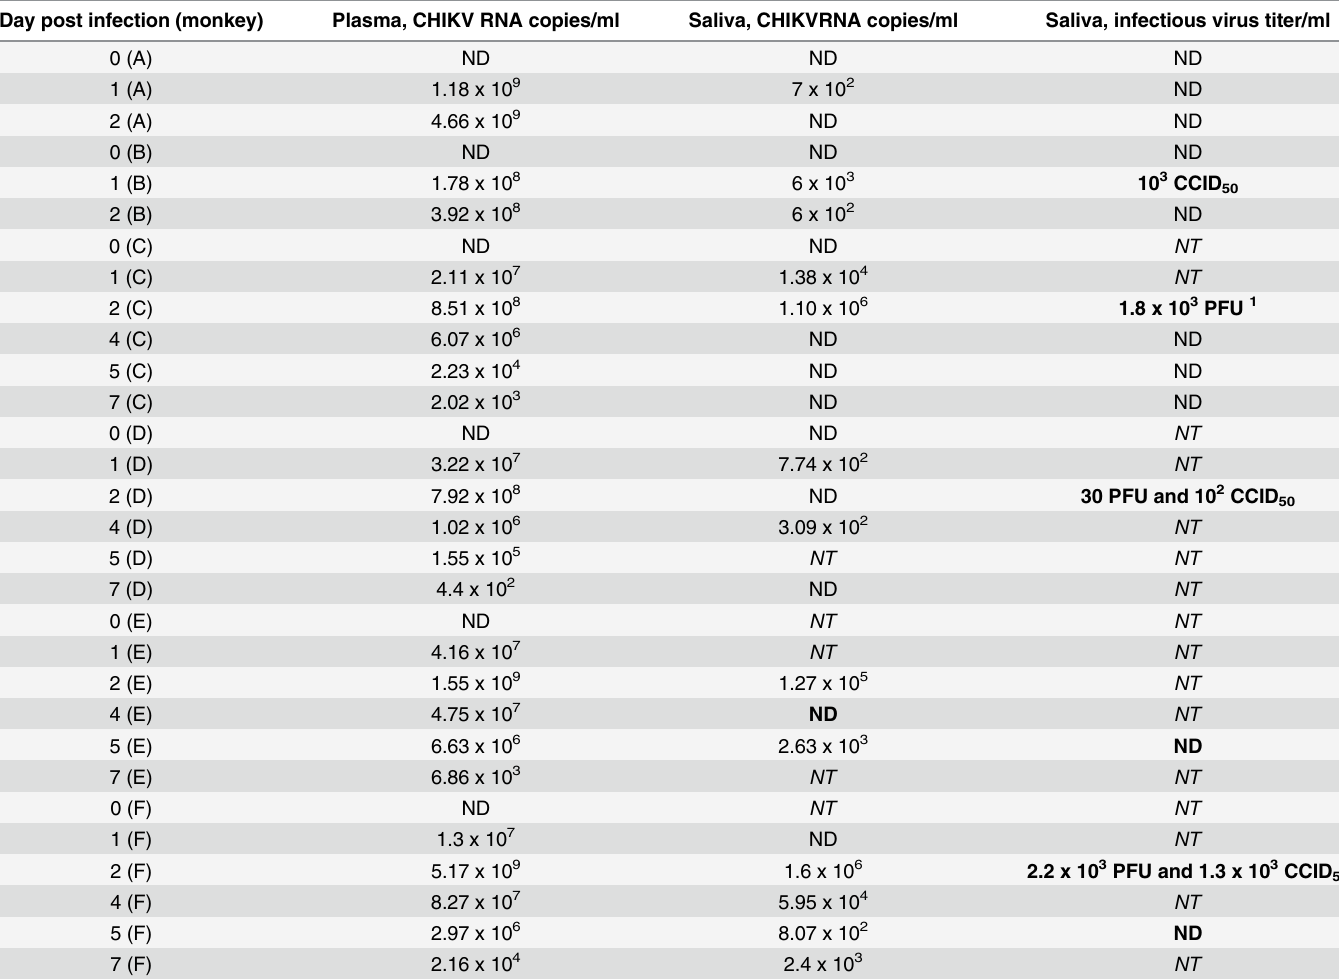
Table 2. Presence of CHIKV RNA and infectious CHIKV in the saliva of CHIKV infected cynomolgus macaques. Monkeys A and B were infected with 10 6 PFU and monkeys C-F with 4 x 10 3 PFU of CHIKV. Viral RNA copies were determined by quantitative real time RT-PCR; (the full data set for animals C-F is graphed in Fig C in S1 File. Infectious virus titers were determined by CCID 50 assay using BHK-21 cells or PFU assay using Vero cells. Day 2 usually repre- sents peak viraemia [16]. ND — not detected. NT — not tested. 1 Blood noted in sample. Where PFU and CCID 50 values were determined, tests were per- formed at different times with different storage